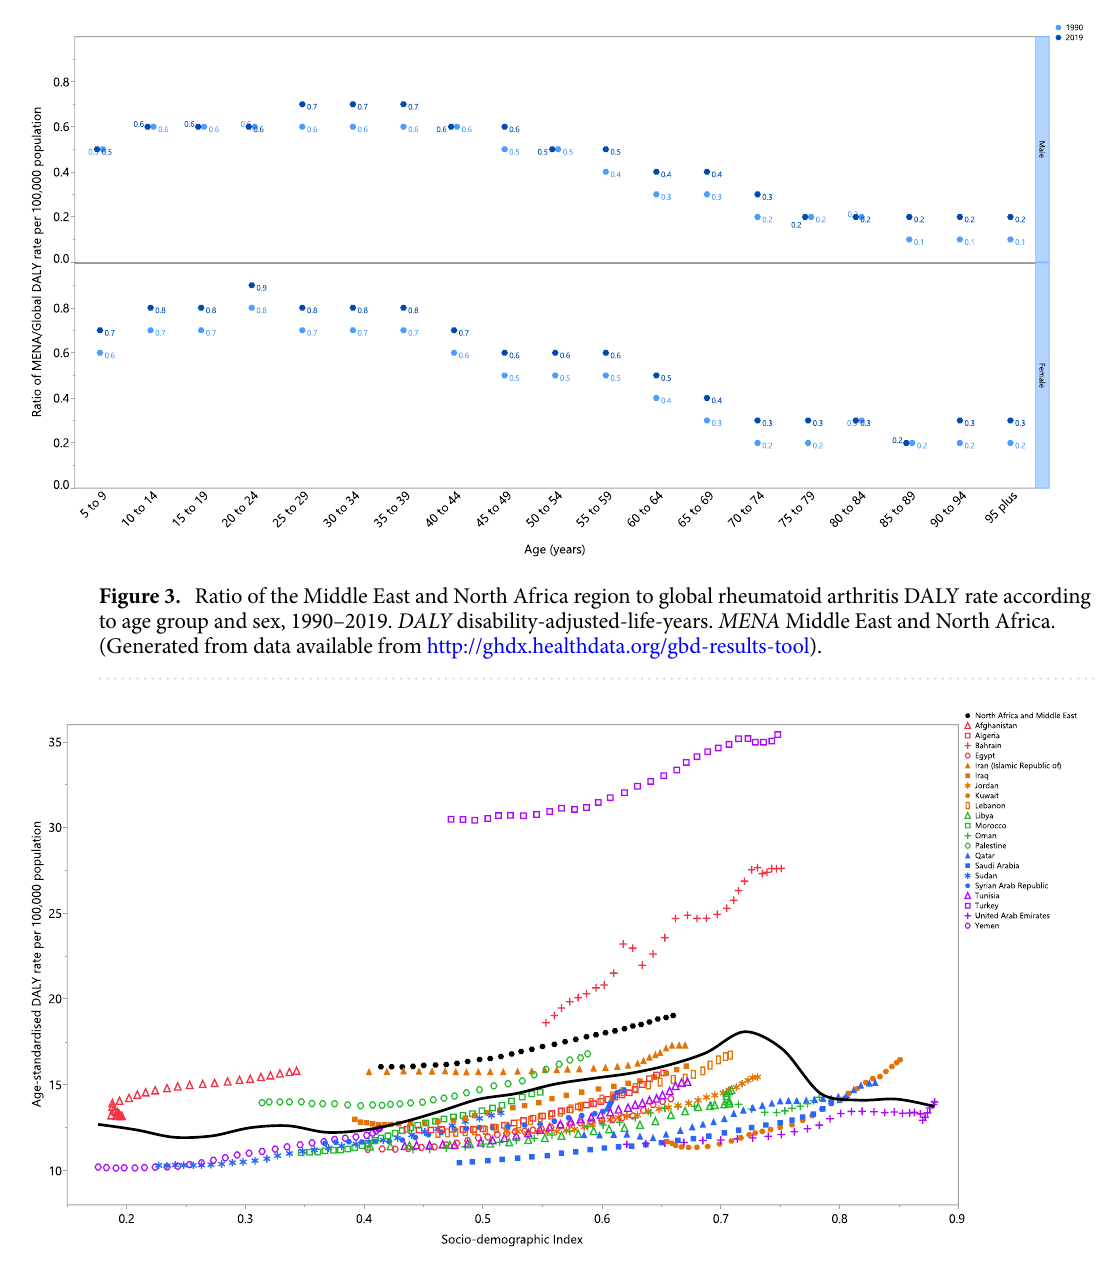
Figure 4. Age-standardised DALY rates of rheumatoid arthritis for 21 countries and territories in 2019, by SDI; Expected values based on the Socio-demographic Index and disease rates in all locations are shown as the black line. Each point shows the observed age-standardised DALY rate for each country in 2019. DALY disability- adjusted-life-years. SDI Socio-demographic Index (Generated from data available from http:// ghdx. healt hdata. org/ gbd- resul ts-